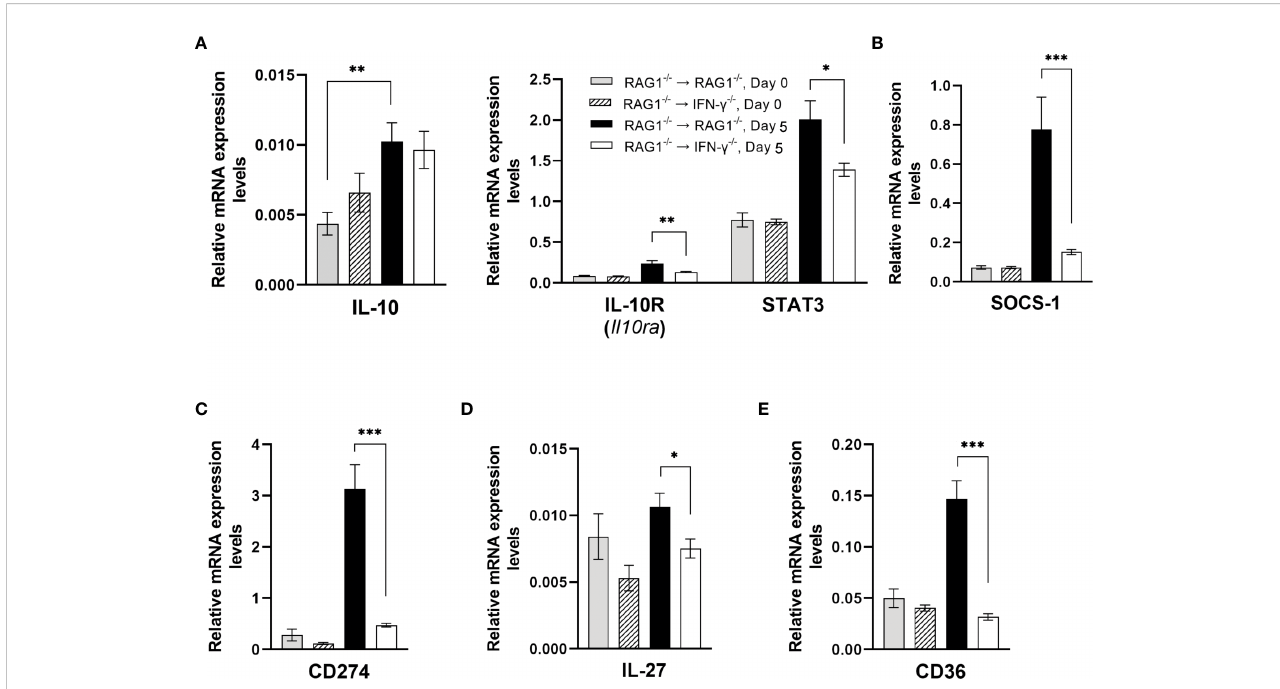
FIGURE 10 Cerebral mRNA levels for the molecules that down-regulate the IFN- g -mediated protective immunity to prevent overly stimulated immune responses are upregulated by IFN- g production by brain-resident cells during reactivation of cerebral T. gondii infection. For the details of experimental methods, see the legend of Figure 1. The mRNA levels for (A) IL-10, IL-10R, STAT3, (B) SOCS-1, (C) CD274, (D) IL-27, and (E) CD36 were measured at both Day 0 and Day 5 in the brains of both groups of mice were measured using NanoString nCounter Mouse Myeloid Innate Immunity Panel. * P <0.05, ** P <0.01, and *** P <0.001. The data were combined from two independent experiments (n=5 for Day 0 and n=7 for Day 5 in both RAG1 -/- → RAG1 -/- and RAG1 -/- → IFN- g -/-